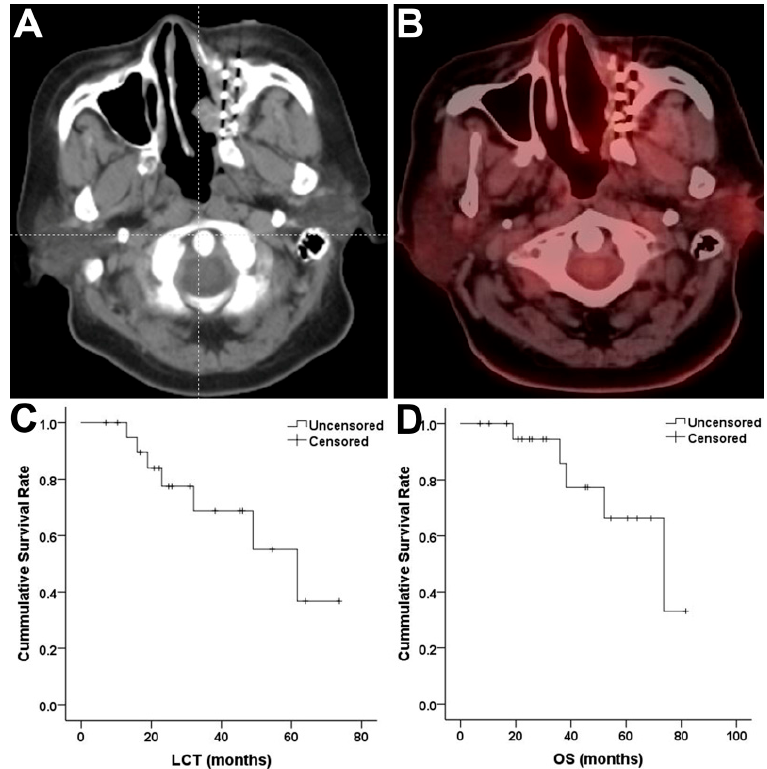
Figure 1. Short-term and long-term efficacy of stereotactic ablative brachytherapy (SABT) for recur- rent head and neck adenoid cystic carcinoma (HNACC). ( A , B ) showed the complete response of one patient 3 months after SABT. ( C , D ) showed the LCT and OS of all